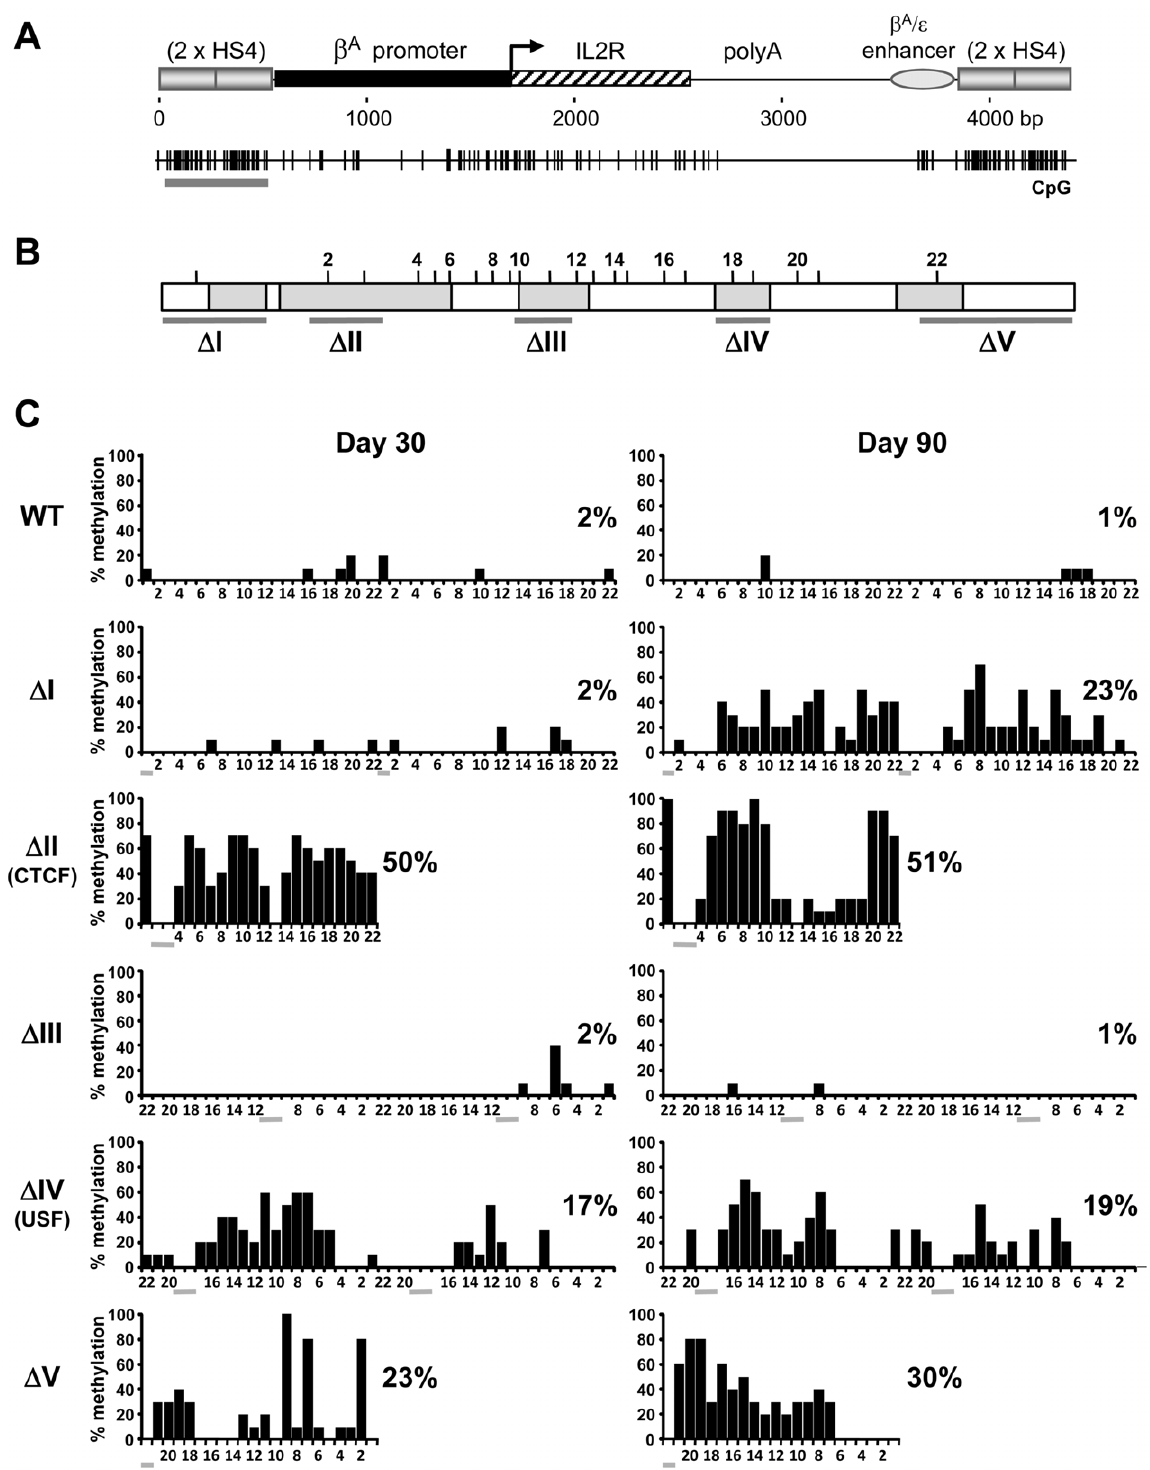
Figure 3. Mutations of insulator protein binding sites result in the denovo methylation of HS4 itself. (A) Schematic representation of the IL-2R transgene including the upstream HS4 elements subject to bisulfite genomic sequencing analysis (gray horizontal bar below CpG plot). (B) Schematic representation of a 275 bp HS4 core element, drawn to scale. Footprinted sequences are shaded gray. CpG locations with their assigned numbers are shown above. Horizontal bars indicate bases subject to deletion. (C) CpG methylation of wild-type (WT) or mutant ( D I - D V) HS4 insulators after 30 (left) or 90 (right) days of culture. Both copies of HS4 were sequenced, except for D II and D V, where only the outermost copy was sequenced (see Materials and Methods). The percentage of methylation for each CpG from 10 clones is plotted. The average methylation for all CpGs is indicated to the right of each plot. Scoring from individual clones can be found in Table S2. Numbers below each histogram refer to CpG numbering as assigned in (B). Horizontal gray bars indicate deleted CpGs. Data are representative of at least two independent transgenic lines, with an average methylation variation of 12% or less.